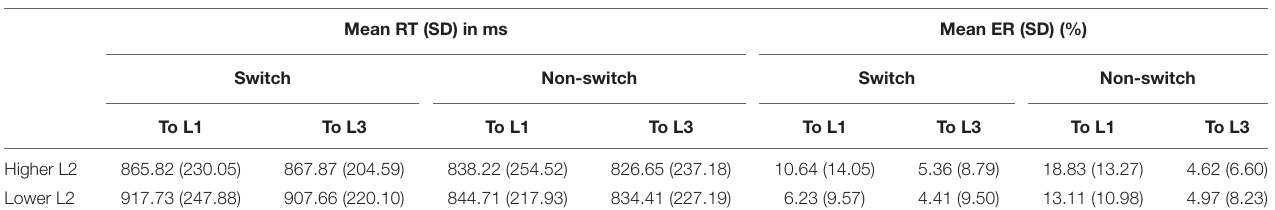
TABLE 3 | RTs and ERs in experiment 2.